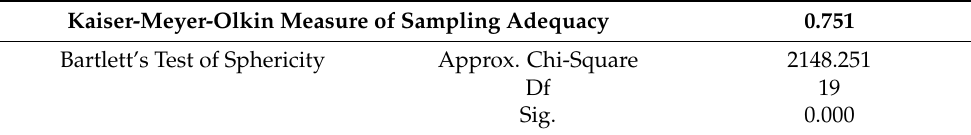
Table 3. Example of KMO and Bartlett values to verify partial correlations between variables.